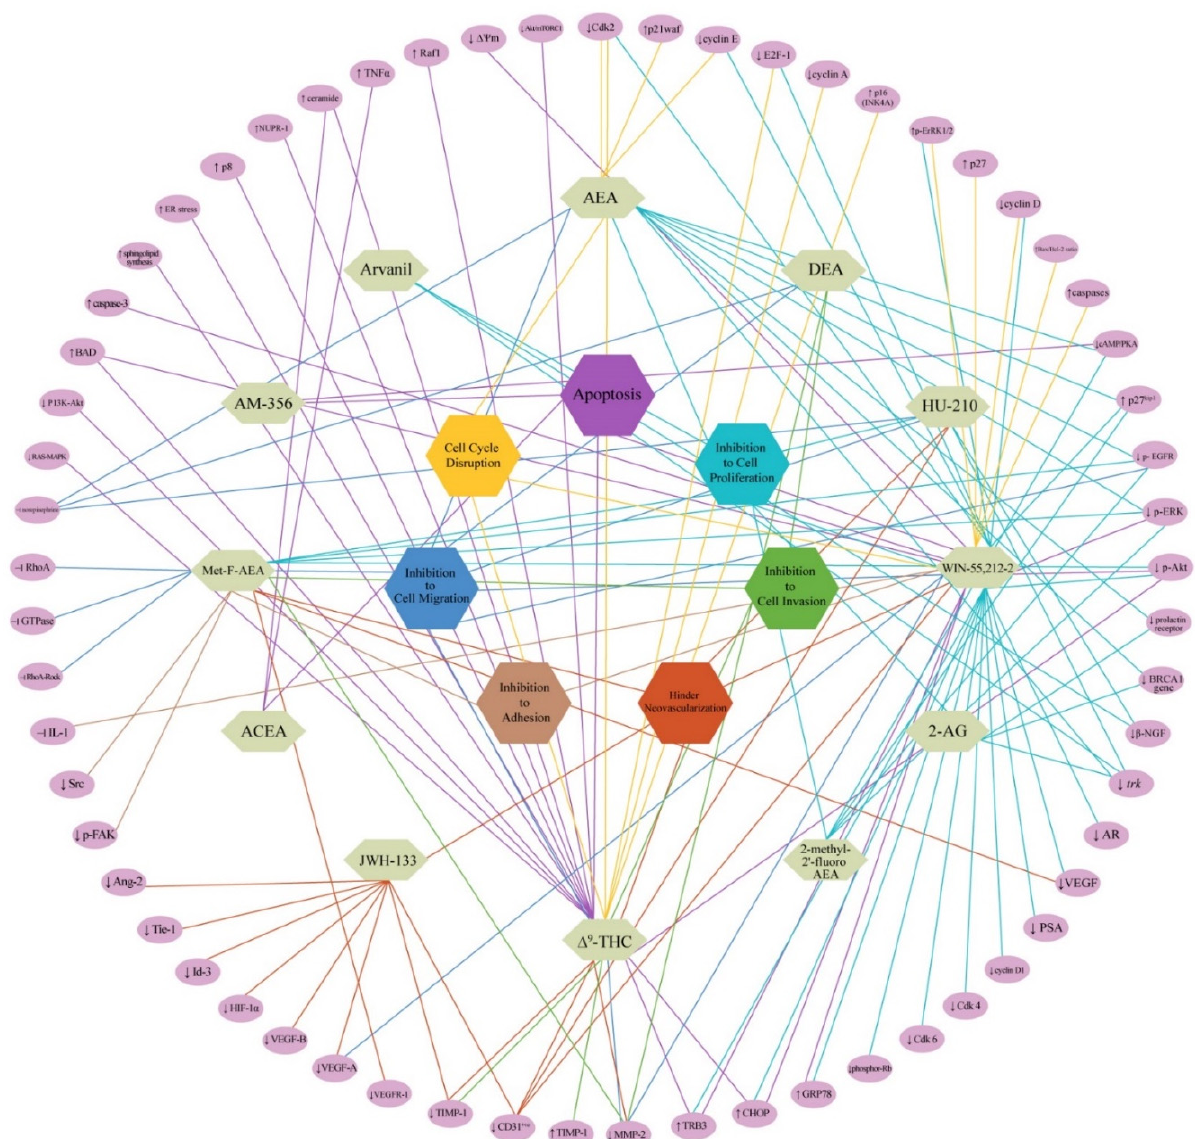
Figure 5. Molecular pathways-based target mapping for endocannabinoids and their mimics [Mode of cell death is com- pletely reviewed and given in hexagonal boxes. Complete molecular target networking indicating expression levels of select proteins is provided as purple ovals in the periphery. Abbreviations: ↑ —increased; ↓ —decreased; ‒ ׀ —inhibition;